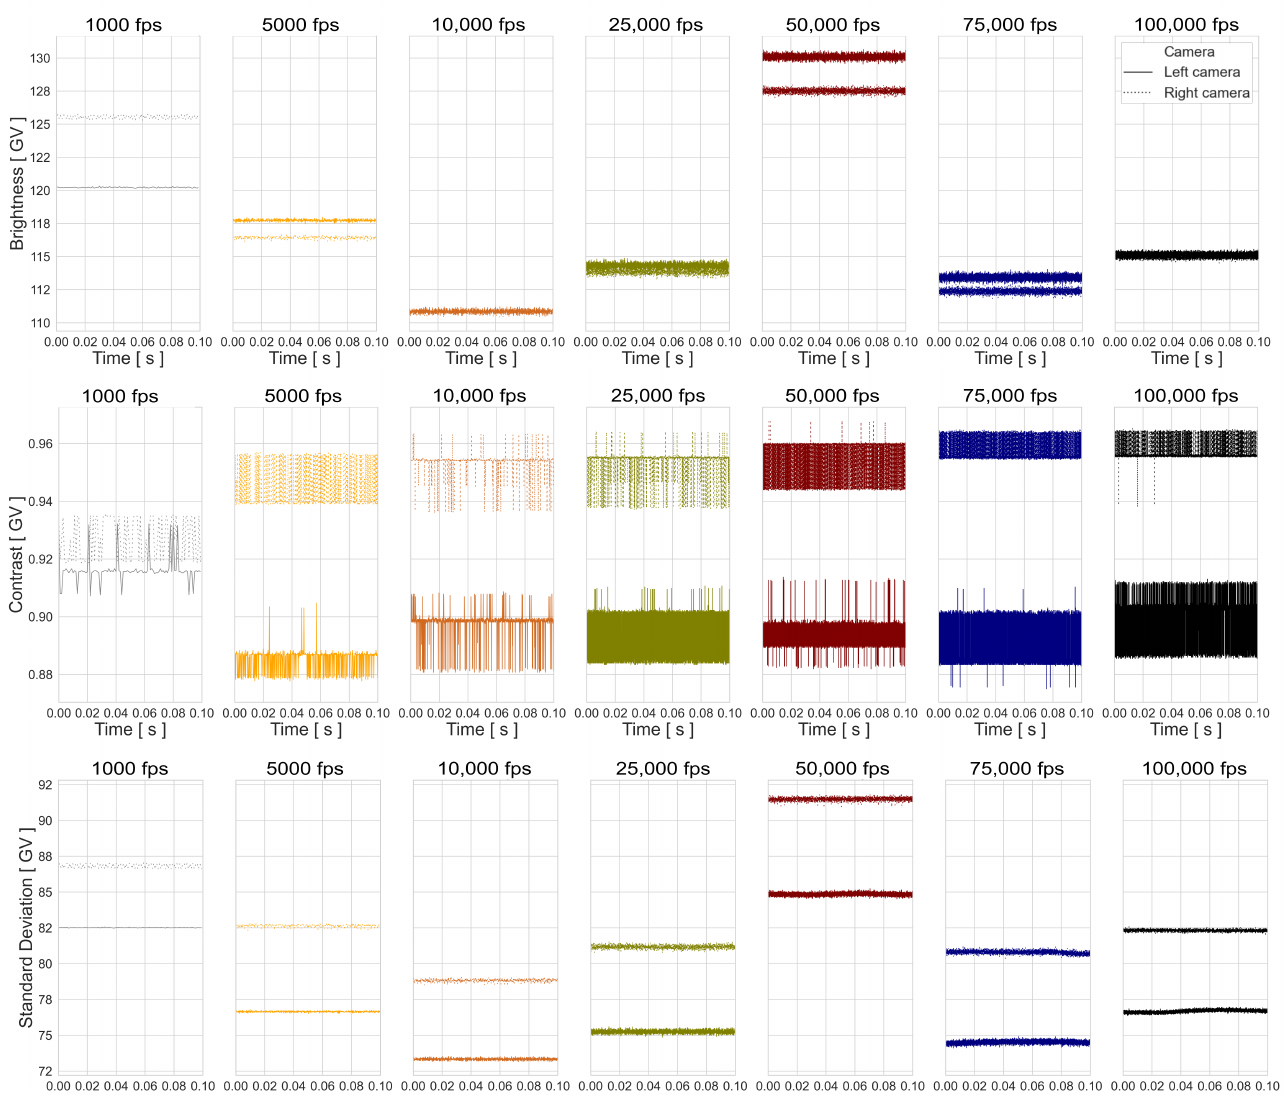
Figure A4. B P , C P , and Std P of images used for the experiment configurations: Static, 01 calibration, and SP